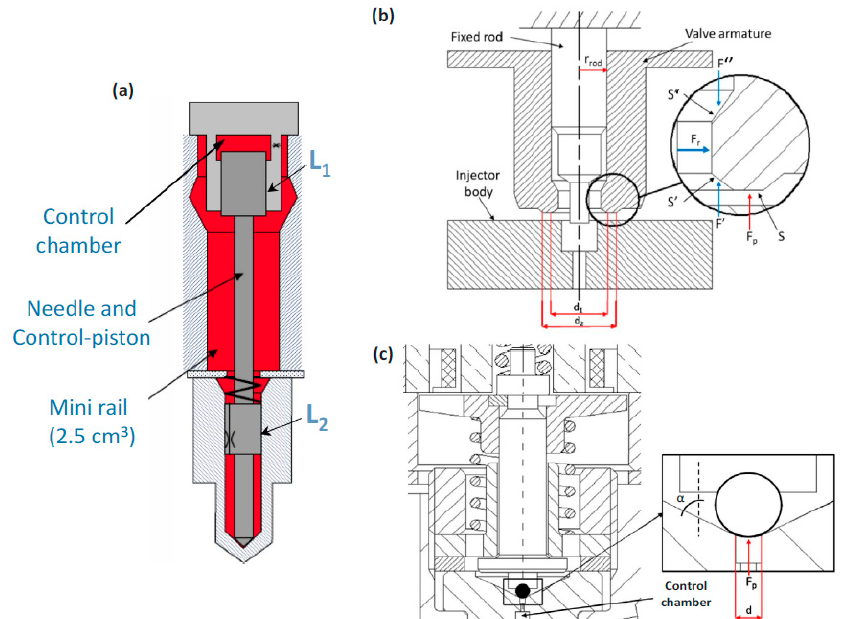
Figure 4. Solenoid injector. ( a ) Hydraulic circuit of the injector; ( b ) Pressure-balanced pilot-valve; ( c ) Standard pilot-valve.